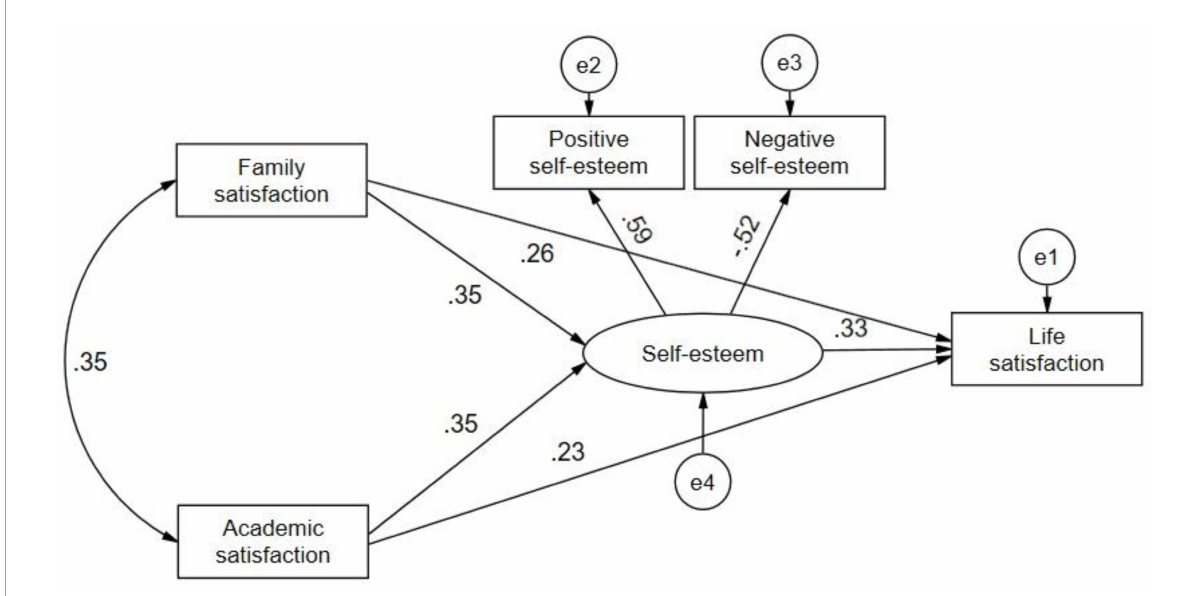
FIGURE2 Results of the structural model explaining life satisfaction. Standardized estimated parameters after controlling for gender and age are shown.